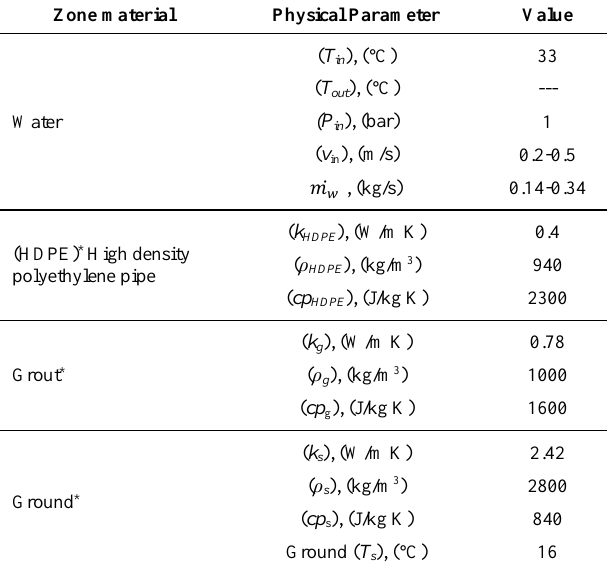
Table 1. Properties and operating conditions of the geothermal